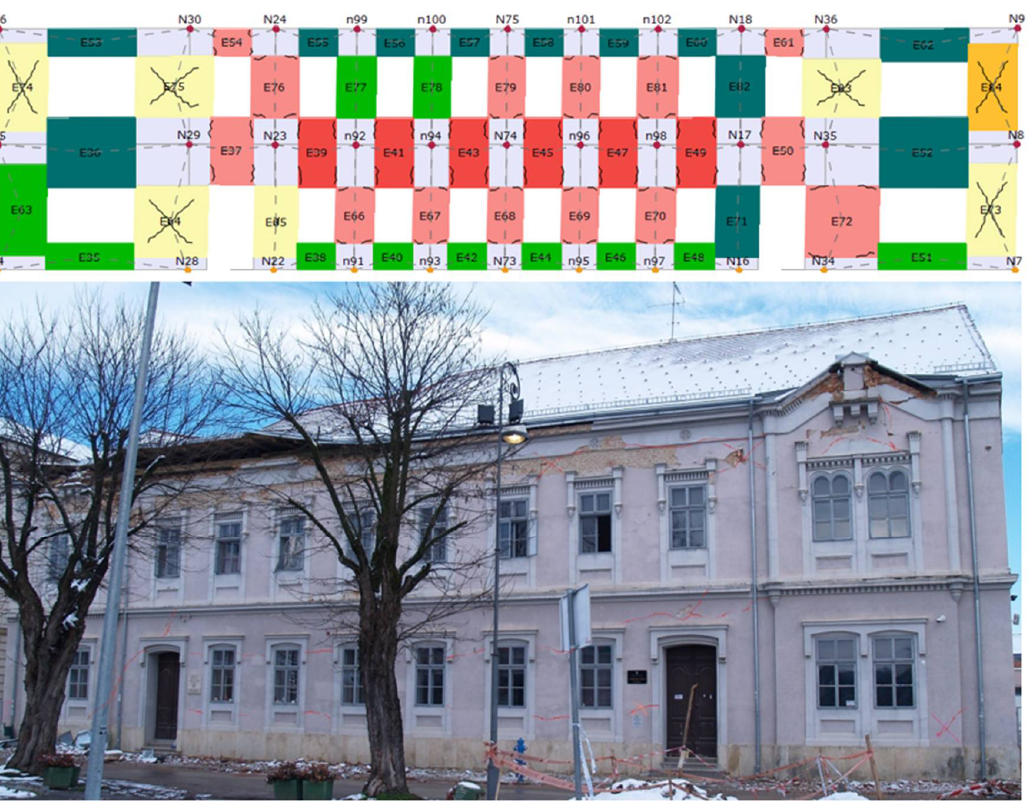
Figure 16. Detailed display of street facade damage in the 3Muri software package and actual damage to the street facade of the building in question.